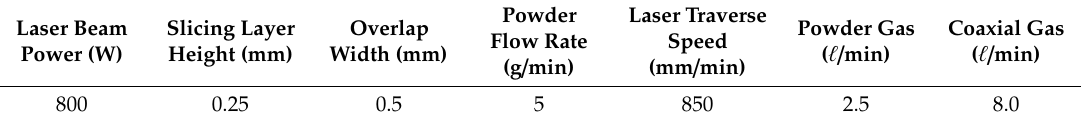
Figure 2. Process of directed energy deposition: ( a ) the pre-heating and deposition of M4 powder; ( b ) deposited M4 layer on the D2 substrate; ( c ) post-heat-treated M4 layer; ( d ) fabrication of a Charpy impact specimen. Table 2. Parameters for direct energy deposition (DED) processing.